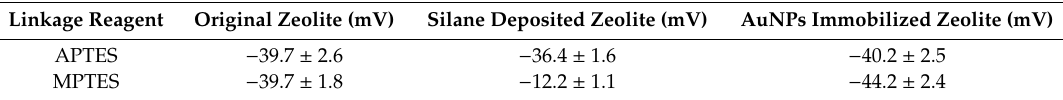
Table 1. Zeta potential of original zeolite, silane modified zeolite and AuNPs immobilized zeolite. Linkage Reagent